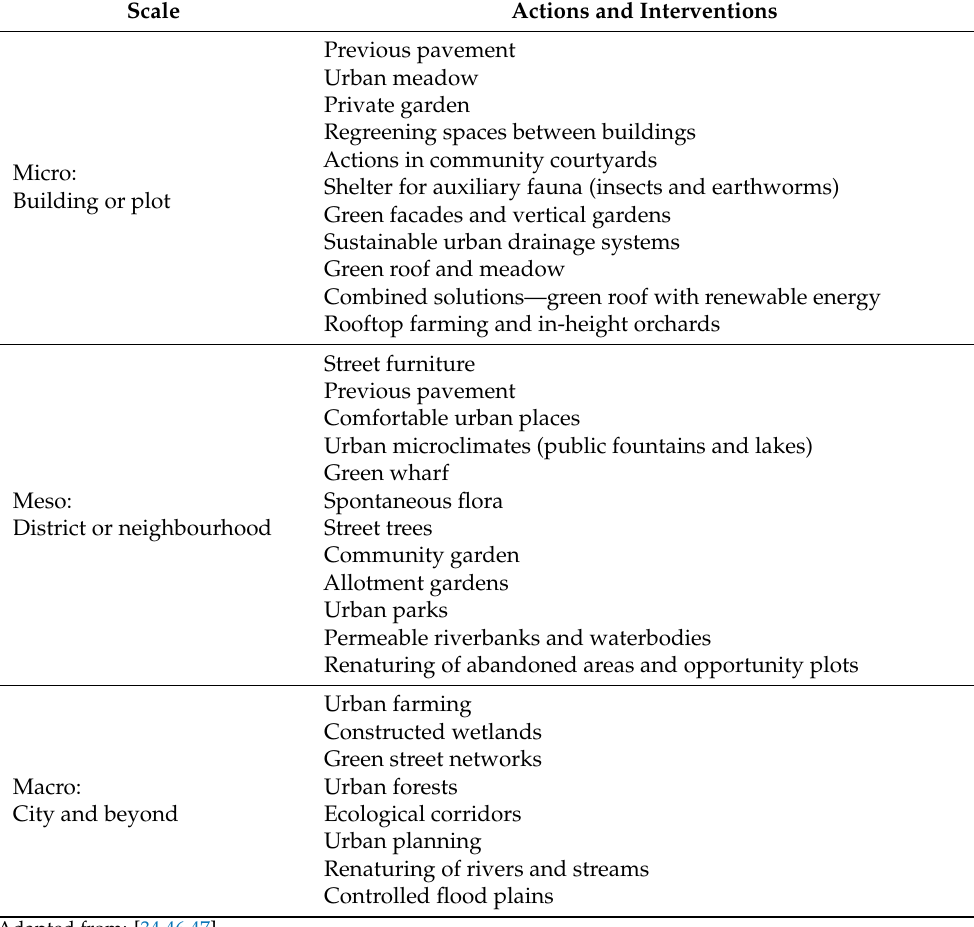
Table 2. Nature-based solutions and actions at different scales in urban